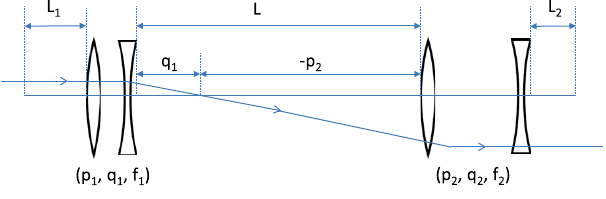
FIG. 3. A schematic layout of a telescope system that consists of two focusing